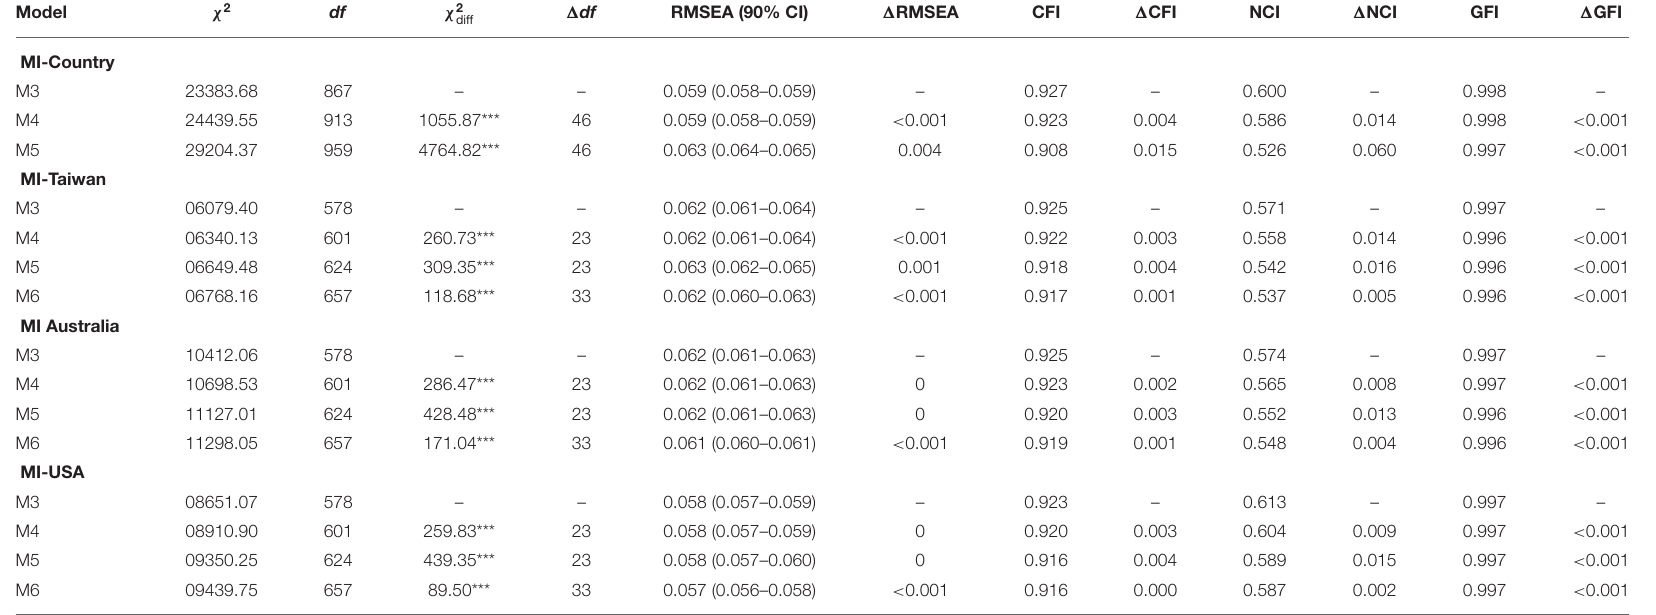
TABLE 3 | Model comparisons for the nested models.